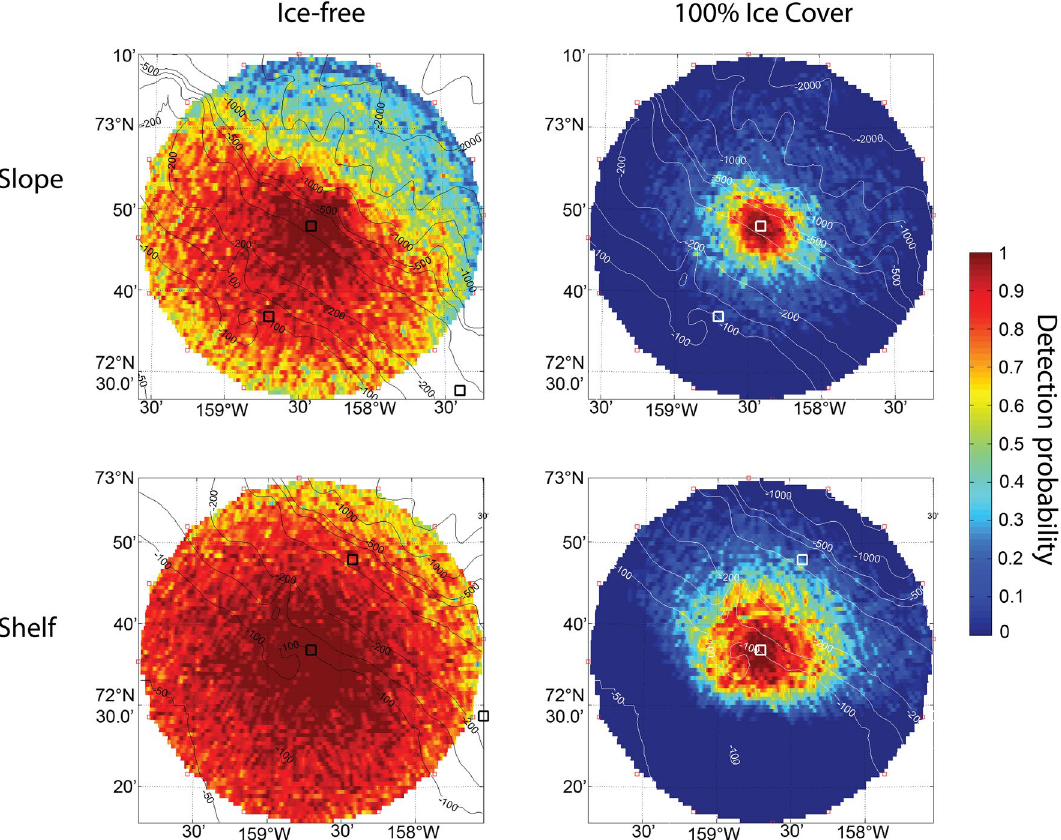
Figure 5. Detection probability for open-water (left panels) and ice-covered (right panels) conditions for slope and shelf recording sites (upper and lower panels) with 70 dB re 1 μPa 2 noise spectrum level in the 80–180 Hz